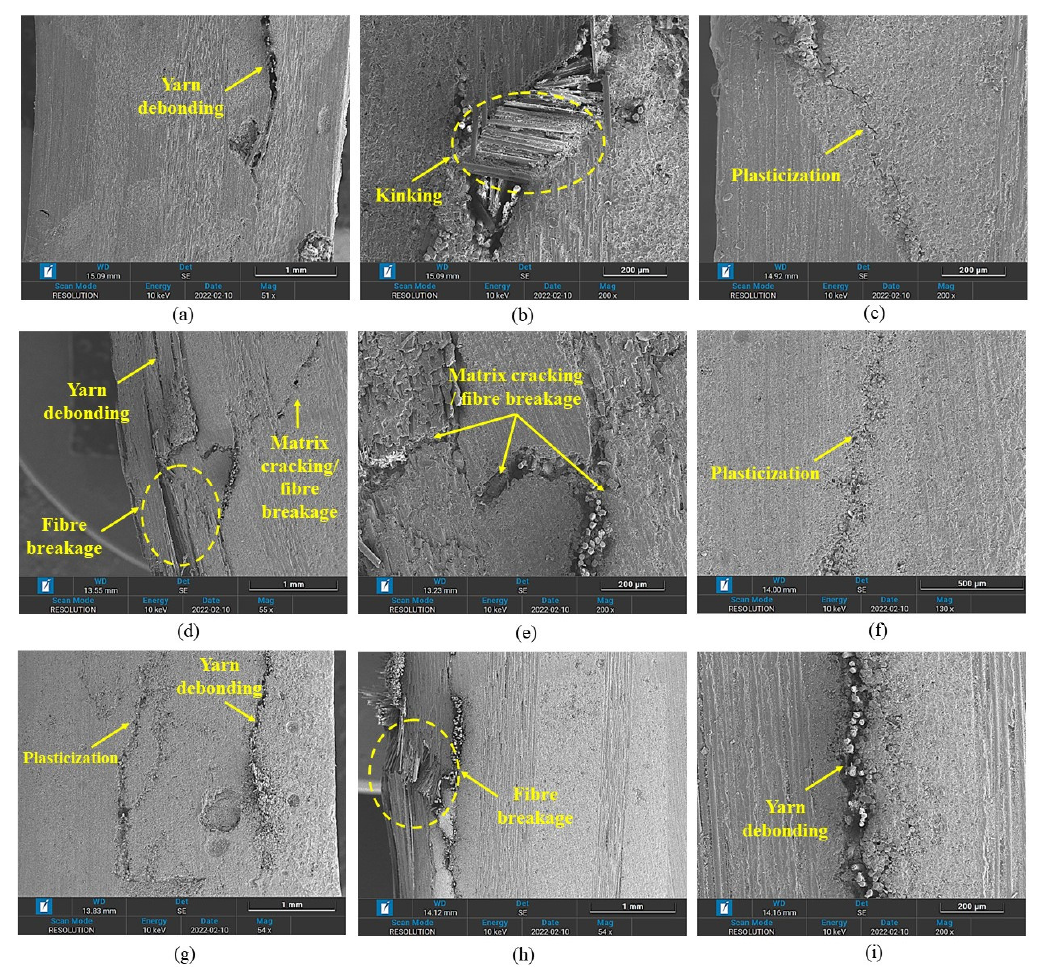
Figure 9. Comparison of intralaminar/interlaminar failure mechanisms in on-axis (0º and 90º) specimens. ( a – c ) 0º TP-3D-FRC, ( d , e ) 0º TS-3D-FRC, ( f , g ) 90º TP-3D-FRC and ( h , i ) 90º TS-3D-FRC.